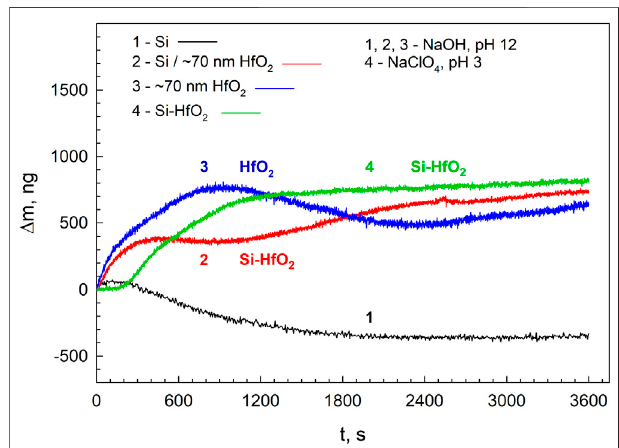
FIGURE 3 | Mass change determined by the QCN of the samples with 70-nm HfO 2 layer on Si (2, 4) and Au (3) substrates when exposed in NaOH (pH 12) (1 – 3) and 1 M NaClO 4 adjusted to pH 3 (4). Curve 1 shows the mass change of hafnia-free silicon pretreated in an HF